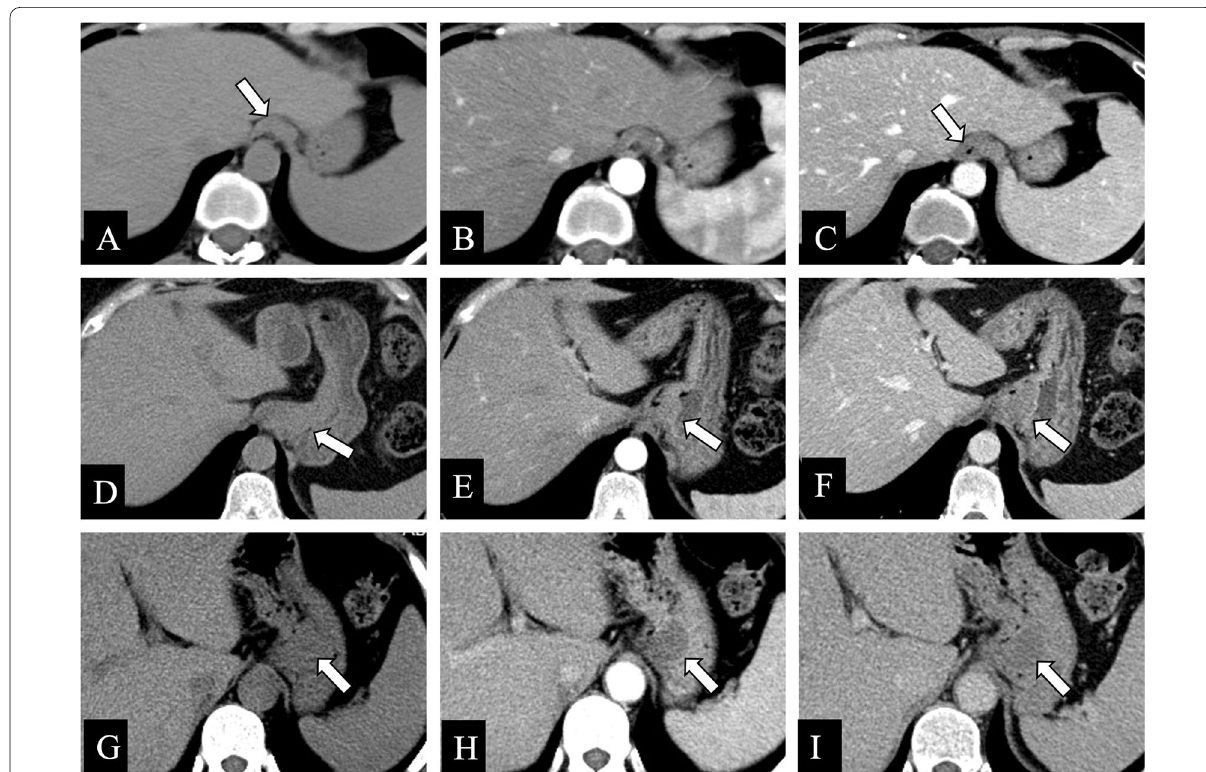
Fig. 10 a–c Heterotopic pancreas in a 48‑year‑old female. Axial contrast‑enhanced CT images obtained during the plain ( a ) /arterial ( b ) /venous ( c ) phase showed a flat mass (white arrows) in the gastric cardia, with a tendency to grow horizontally. d–f Gastrointestinal leiomyoma in a 42‑year‑old male. Axial contrast‑enhanced CT images also demonstrated a same flat mass (white arrows) in the gastric cardia, but with a vertical growth tendency compared to the horizontal axis. g–i Gastrointestinal leiomyoma in a 48‑year‑old female. Axial contrast‑enhanced CT images also revealed a vertically growing and round mass (white arrows) in the gastric